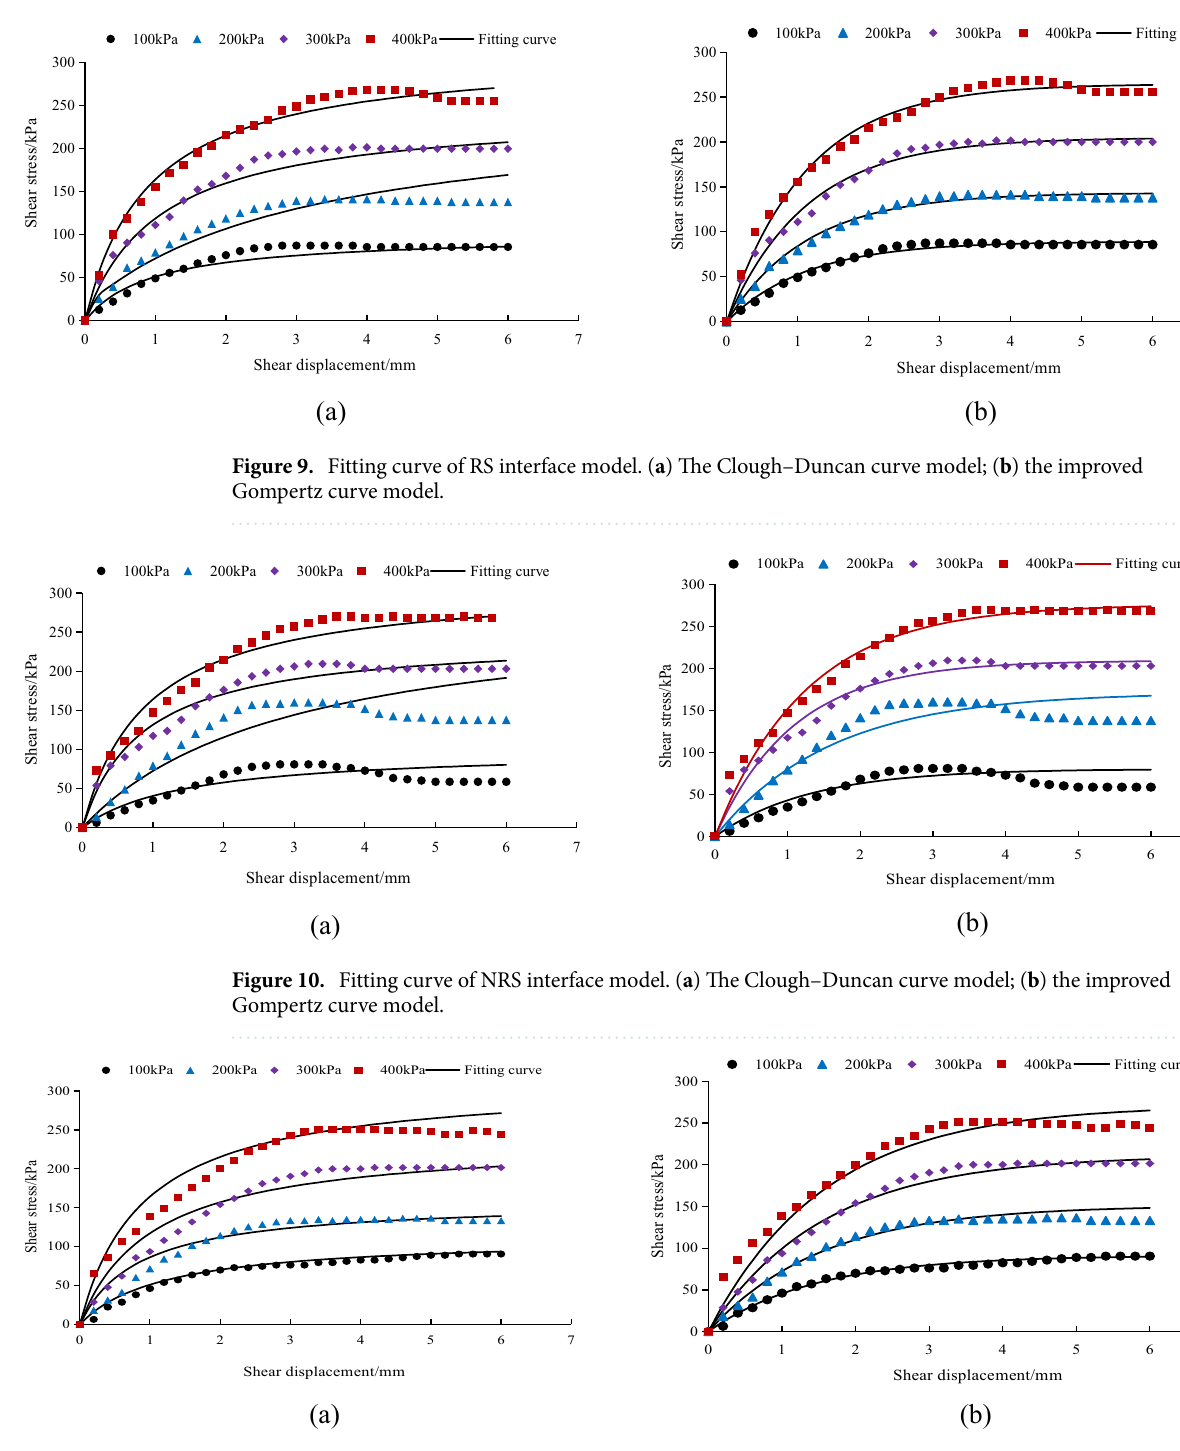
Figure 11. Fitting curve of GRS interface model. ( a ) The Clough–Duncan curve model; ( b ) the improved Gompertz curve